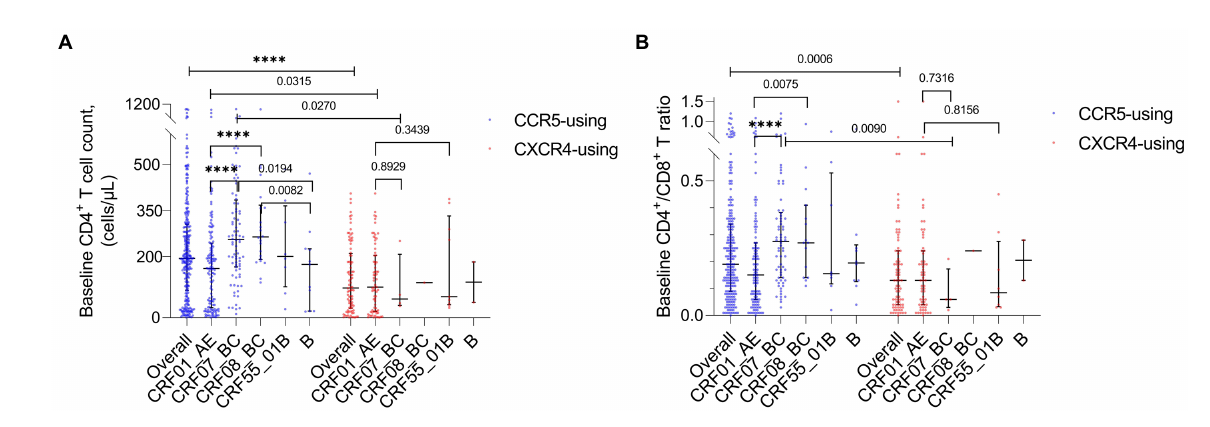
FIGURE 4 (A) Baseline CD4 + T cell count of all HIV-1 subtypes and overall tropism. (B) Baseline CD4 + T/CD8 + T ratio of all HIV-1 subtypes and overall tropism.